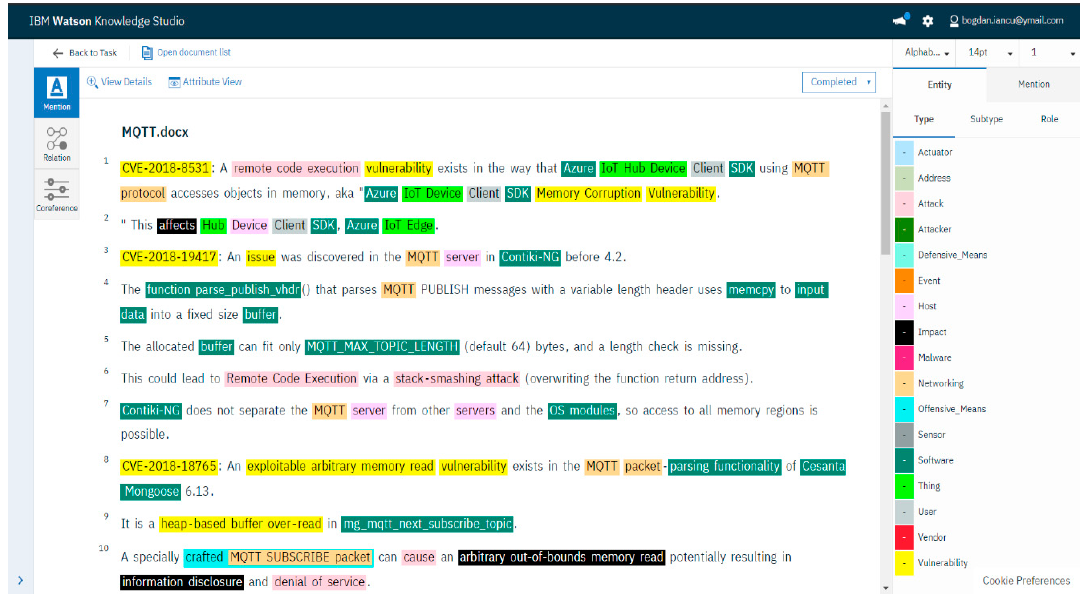
Figure 4. A screen capture of the training process for entity recognition from Knowledge Studio. Figure 5 illustrates the relations for one paragraph of the training data.